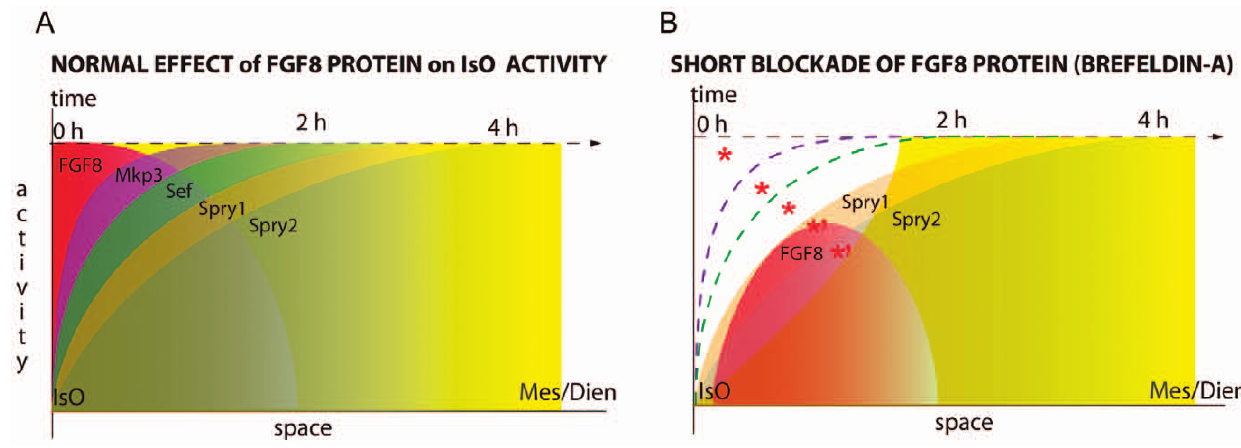
Figure 7 . Initial FGF8 planar instruction effects in IsO after a short signaling deprivation. Schematic representation of isthmic FGF8 feedback modulator genes regulation given by the isthmic gradiental FGF8 morphogen (and signaling) on the mouse mesencephalon. The graphic describes the distribution of dosage (activity) versus time and space of FGF8 and of Fgf8 negative signal modulators. A) represents the normal FGF8 signal activity in the IsO (high levels of FGF8 protein; red solid wedge), during which FGF8 maintains at dose-dependent manner the different FGF negative modulators expression profile starting from Mkp3 (purple solid curve), Sef (green) and finishing Sprouty genes (where low levels of FGF8 protein). The yellow background represents ERK activity. B) describes the presumed situation during Brefeldin a (BFA) treatment (4 hours) on the FGF8 morphogenetic activity. Thus, at isthmus the FGF8 protein level (a therefore morphogenetic activity: red solid bell-shaped curve) would be cero but some residual protein away from the source would still activate ERK (yellow solid slope curve). Inside this negative gap of ERK1/2 activity the expression of Mkp3 (purple dashed curve line) and Sef (green dashed curved line) at the mesencephalon is completely absent. Nonetheless the residual FGF8 morphogen apart from the isthmus is enough to maintain Sprouty1/2 expression in the mesencephalon in the absence of ERK activity (red asterisks’; see also [32,76]).